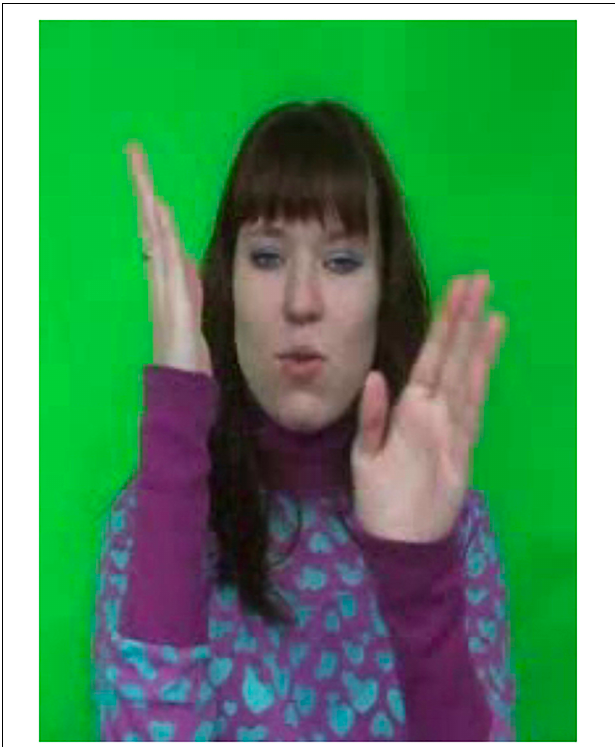
FIGURE 6 | RSL sign weather. Reproduced with permission from Svetlana Burkova (Novosibirsk State Technical University), available at the online corpus of Russian Sign Language,